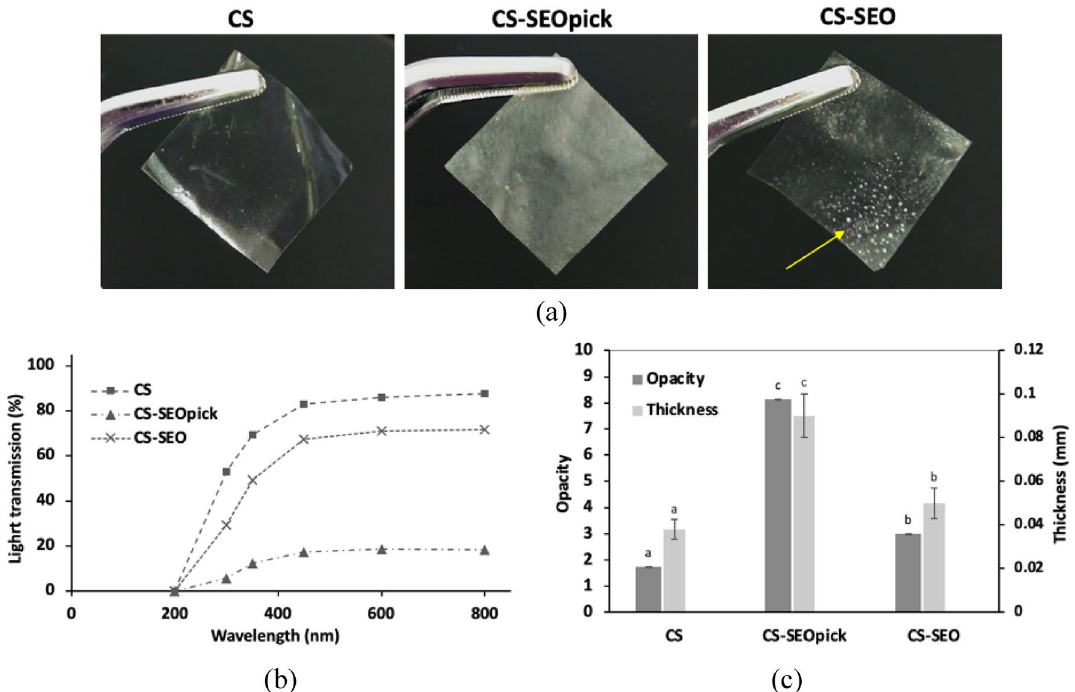
Figure 6. Visual photographs of coating film appearance ( a ) and its optical properties; light transmittance ( b ) and opacity and thickness for thin coating film ( c ). Different letters indicate statistically significant differences at P < 0.05. CS chitosan, CS-SEOpick chitosan–sandalwood oil Pickering emulsion, CS-SEO chitosan–sandalwood oil regular emulsion